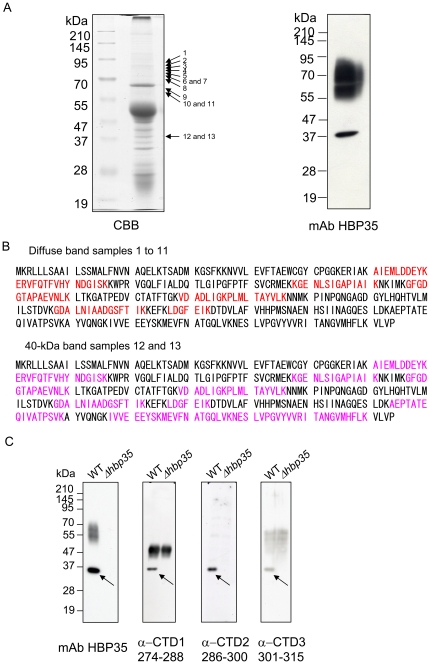
Peptide map fingerprinting (PMF) and immunoblot analyses of the diffuse HBP35 protein.(A) CBB staining and anti-HBP35 immunoblotting of anti-HBP35 immunoprecipitates from P. gingivalis cell lysates. Immunoprecipitates from the cell lysates of the rgpA rgpB kgp mutant were separated by SDS-PAGE, and the resulting gel was stained with CBB (left panel) or probed with a mAb against HBP35, mAb-Pg ompA2 (right panel). Arrows indicate the positions of samples 1 to 11 collected from the diffuse HBP35 protein bands and those of samples 12 and 13 collected from the 40-kDa HBP35 protein band. (B) PMF analysis. Peptide fragments (red in the upper sequence) were identified in the 11 samples of the diffuse HBP35 protein, and peptide fragments (pink in the lower sequence) identified in the 2 samples of the 40-kDa HBP35 protein. (C) Immunoblot analysis of P. gingivalis with antibodies against peptides in the CTD region of HBP35. Cell lysates of P. gingivalis 33277 (WT) and KDP166 (Δhbp35) were subjected to SDS-PAGE and immunoblot analysis with an mAb against HBP35, anti-CTD1 [A274-V288], anti-CTD2 [P286-E300] and anti-CTD3 [E301-L315]. Arrows indicate the 40-kDa HBP35 protein.